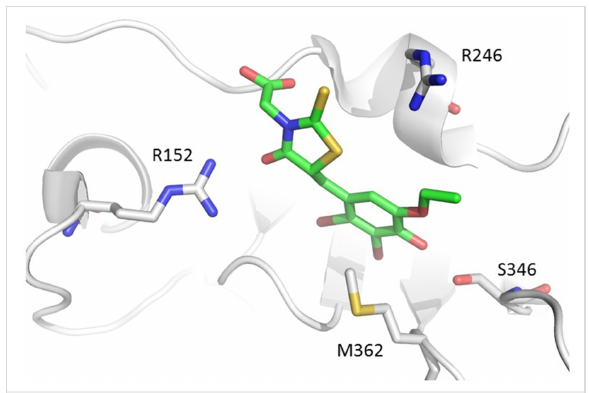
Figure 4: Crystal structure of the RU7 ( 9 )-sliding clamp complex (PDB code 3D1G; adapted from Georgescu et al. [58]). Essential residues R152, M362, S346 and R246 are highlighted